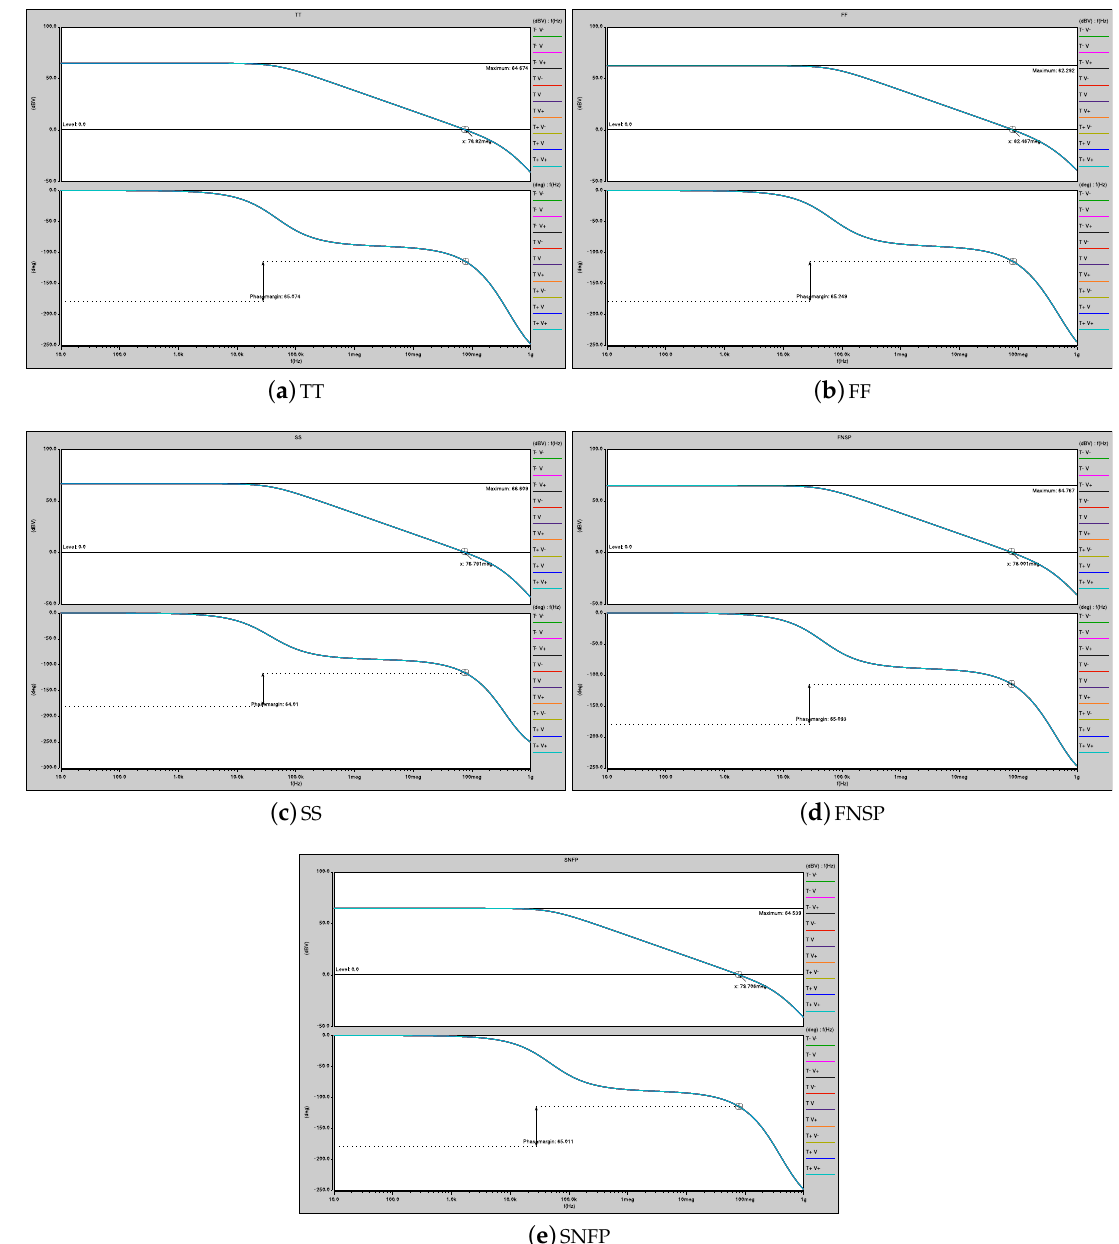
Figure 10. Simulations of PVT variations guaranteeing the DCOP given in (2) for the feasible solutions of the